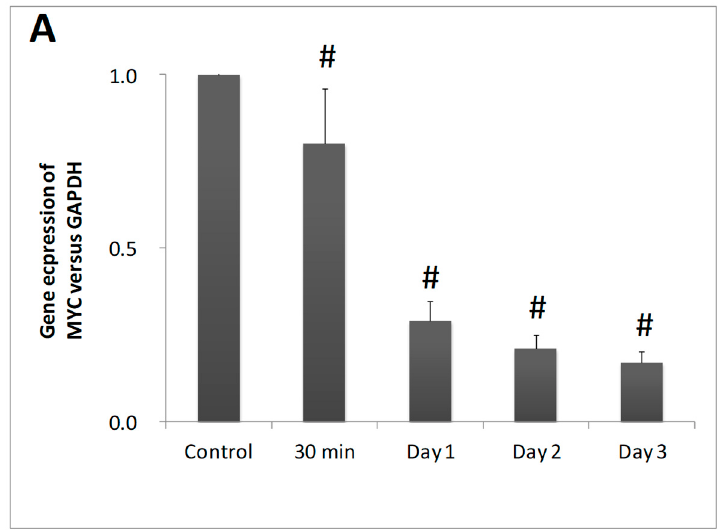
Figure 2. Effect of DHA treated EoL-1 cells upon MYC -mRNA levels. MYC -mRNA levels from EoL-1 cells in the absence (control) or presence of 10 µ M DHA by qRT-PCR analysis ( n = 3, in duplicates). The symbol # denotes statistically significant differences of p < 0.05 versus control. t -Test analysis for independent samples was applied by Statistica software.